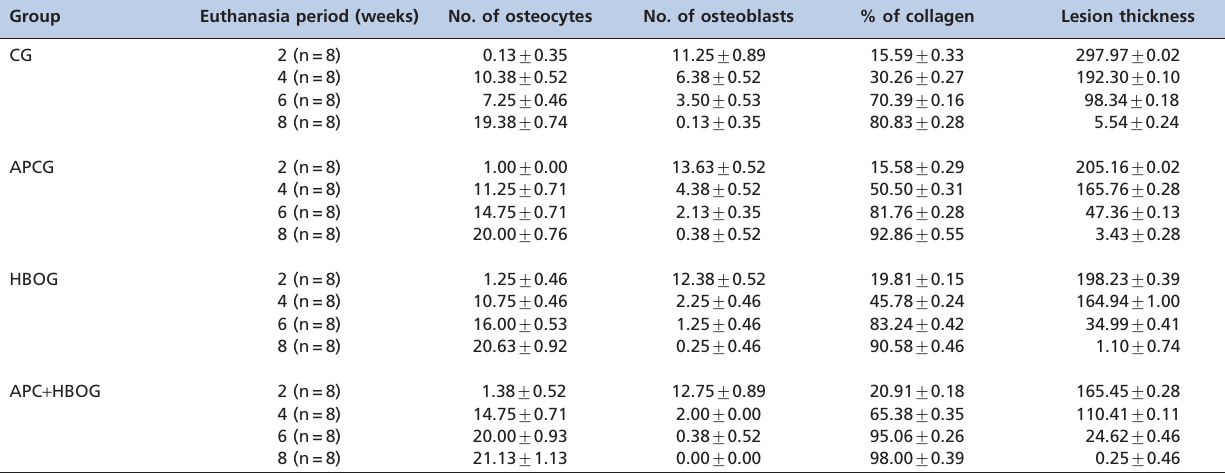
Table 1 - Summary measurements (average ¡ standard deviation) of the percentage of collagen, number of osteoblasts and osteocytes, and lesion thickness, according to groups and euthanasia periods (subgroups). Group Euthanasia period (weeks) No. of osteocytes No. of